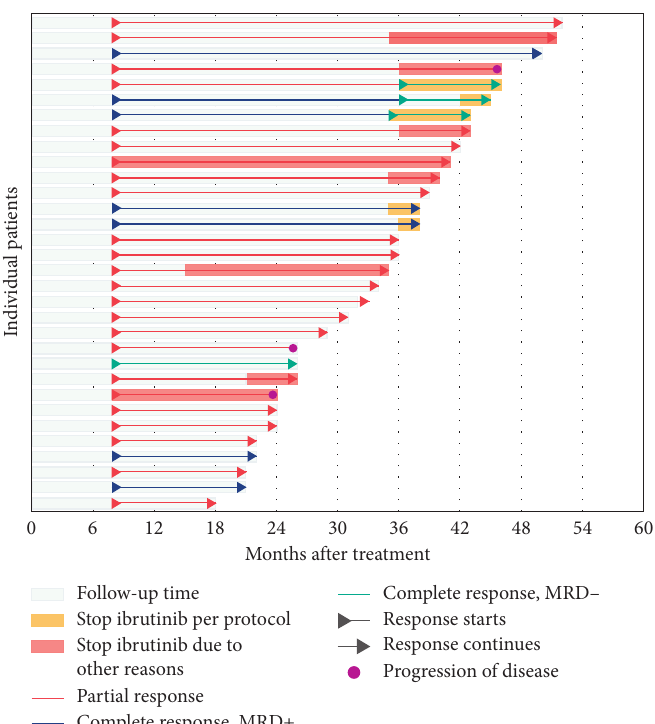
Figure 4: Swimmers plot of patients enrolled. This figure provides a snapshot of all patients enrolled in the study that received medication. Each bar represents one subject in the study. Patients started treatment at time point zero. First response assessment occurred eight months after initiations of therapy according yo iWCLL 2018